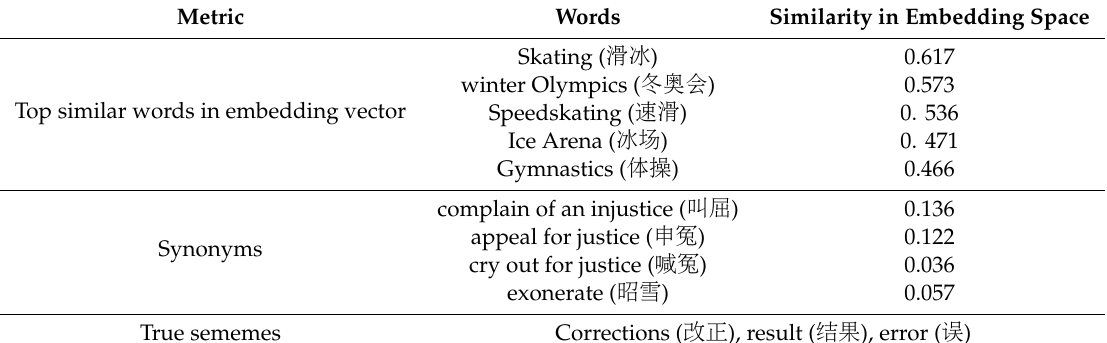
Table 1. Comparison of the synonyms words and the top similar words in embedding space of “Shen Xue ( 申 雪